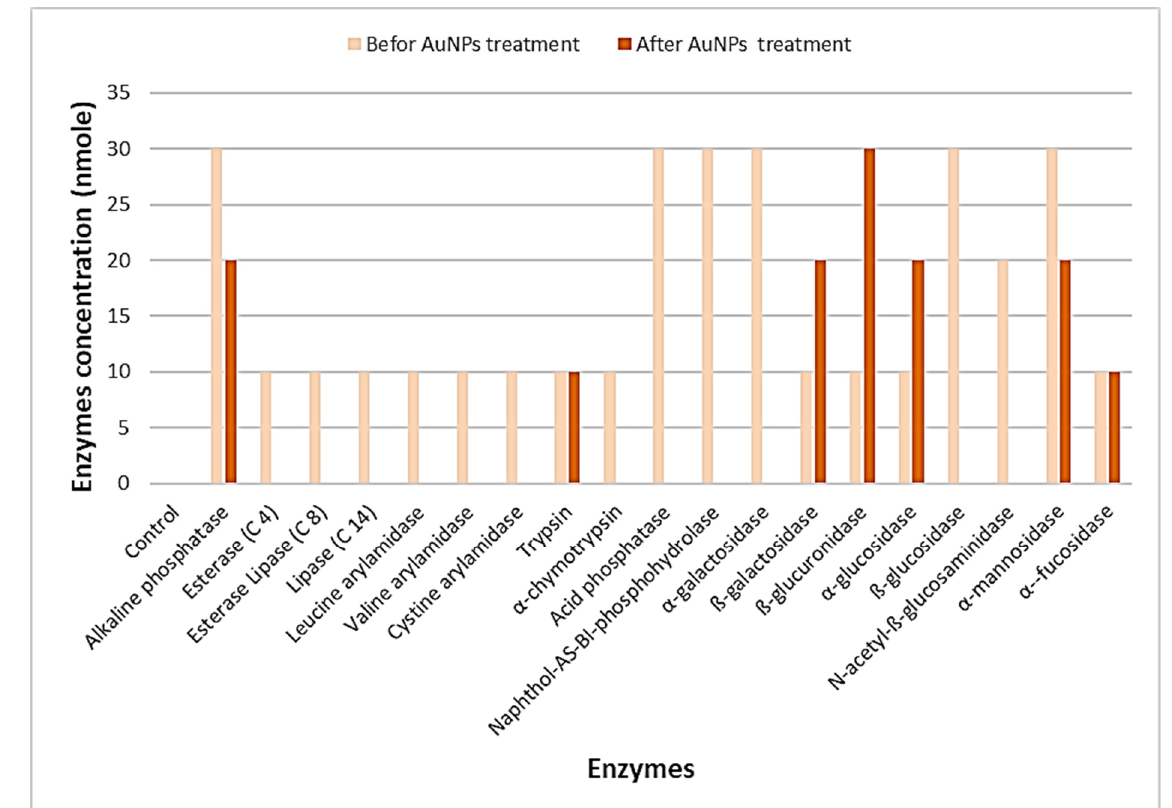
Figure 8. Effects of AuNPs on the activity of extracellular enzymes of A. flavus (AM11).